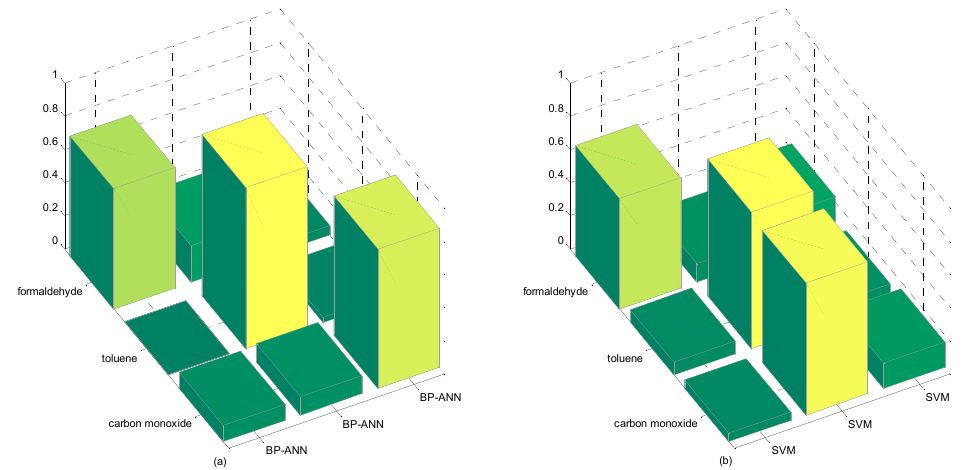
Figure 11. Accuracy rate of the two conventional nonlinear supervised methods. These are the classification results based on three target gases with conventional nonlinear supervised methods which are BP-ANN ( a ) and SVM ( b ). It is obvious that these two algorithms all perform well in specific gas classification. However, their performance get worse while applied to other gases classification.